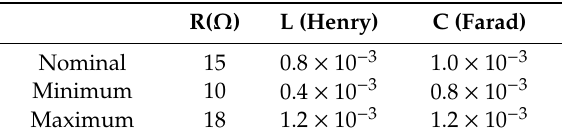
Table 1. Ranges of values for the PV plant transfer function.